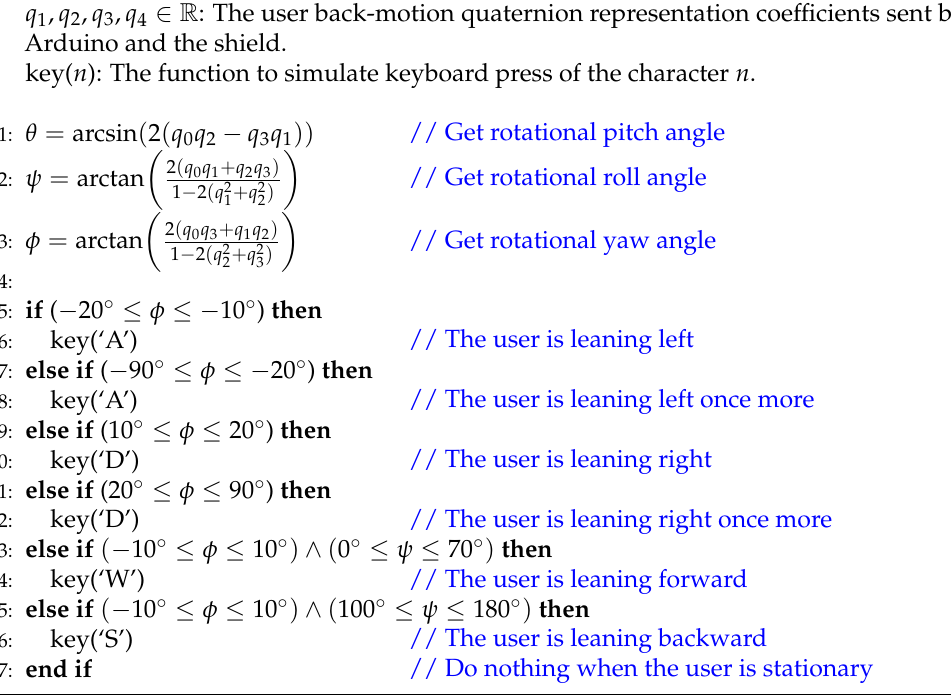
Algorithm 3 The back-controller flow